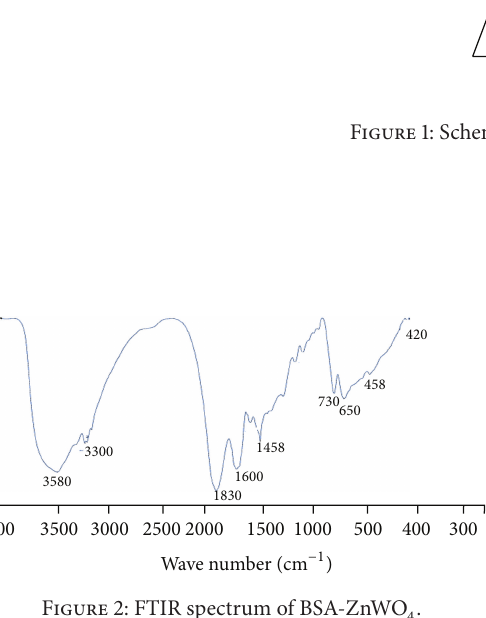
Figure 2: FTIR spectrum of BSA-ZnWO 4 .